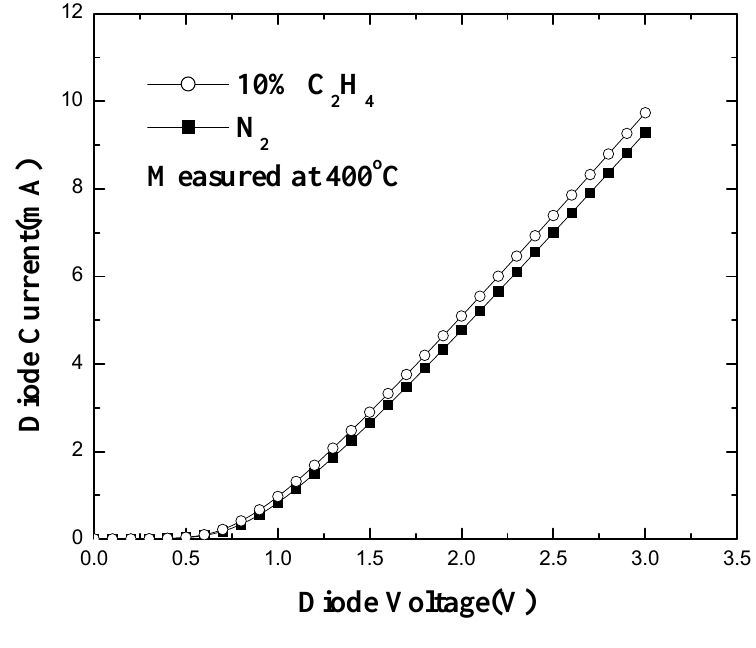
or 10% C H /90% N 2 2 4 2